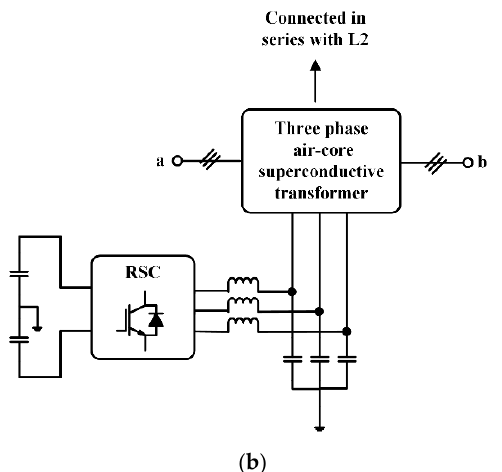
Figure 9. ( a ) The superconducting fault current limiter–magnetic energy storage system (SFCL-MES) [33,34]; and ( b ) the active superconducting fault current limiter [35].